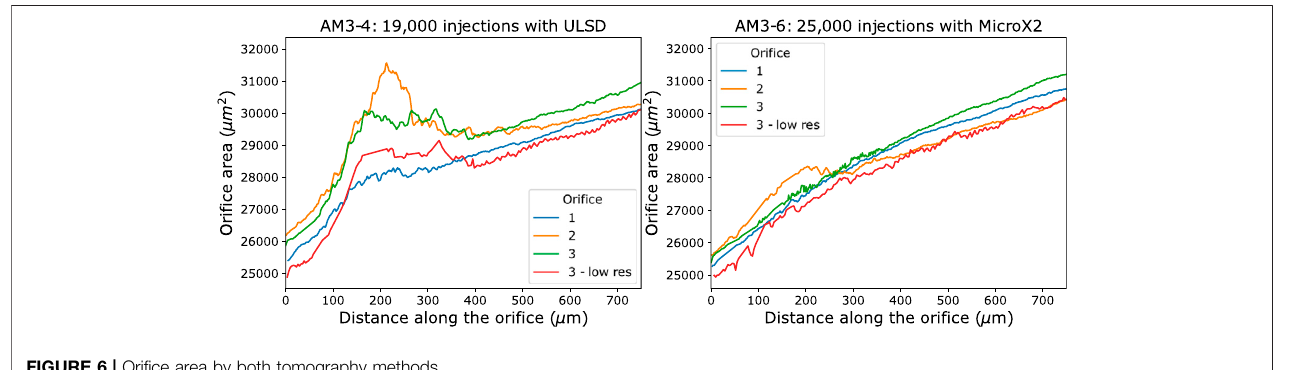
FIGURE 6 | Ori fi ce area by both tomography methods.